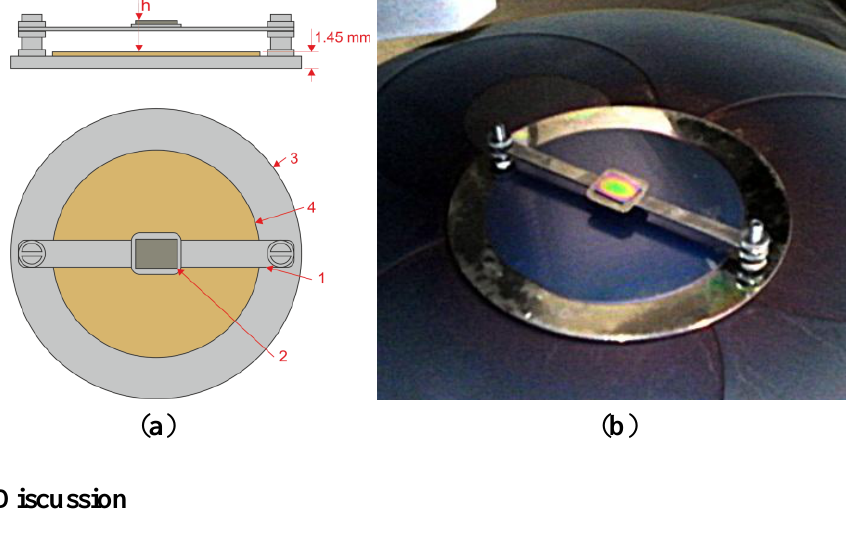
Figure 1. The holder used for elevation of the samples in the reactor, where ( a ) shows its schematic representation with 1: an elevator bar, 2: silicon wafer, 3: stainless steel holder, 4: flattening 3-inch silicon wafer; and ( b ) shows a picture of the holder with a Si sample placed on the elevator